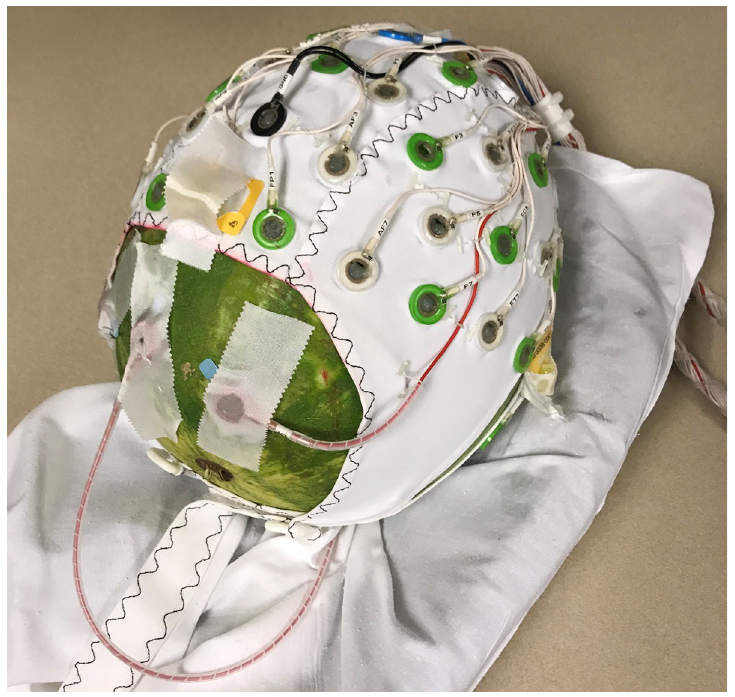
Fig 1. Watermelon ‘phantom’ outfitted with the 64-channel BrainProducts EEG cap.